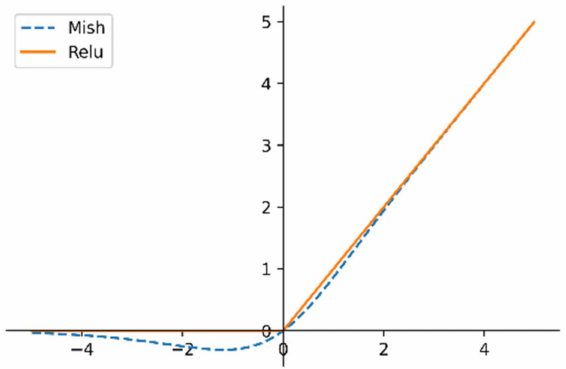
Figure 4. Comparison of Mish and Relu activation